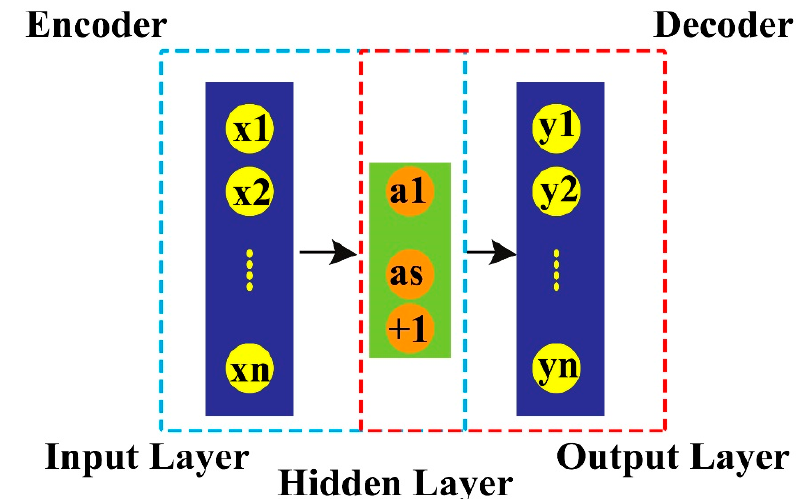
Figure 10. An architecture of an auto-encoder.